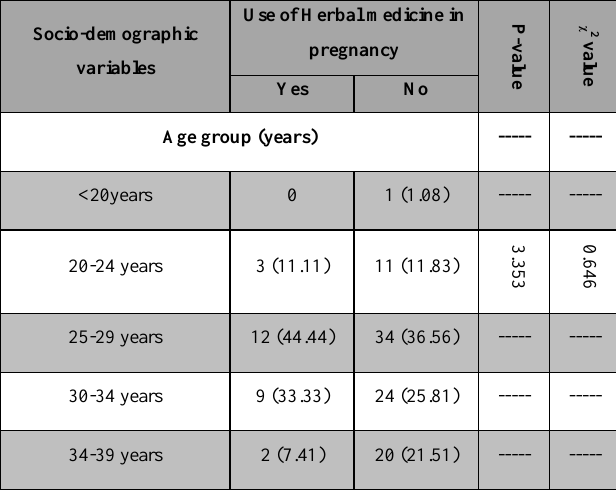
Table 5. Association between the socio-demographic characteristics and the use of Herbal medications during